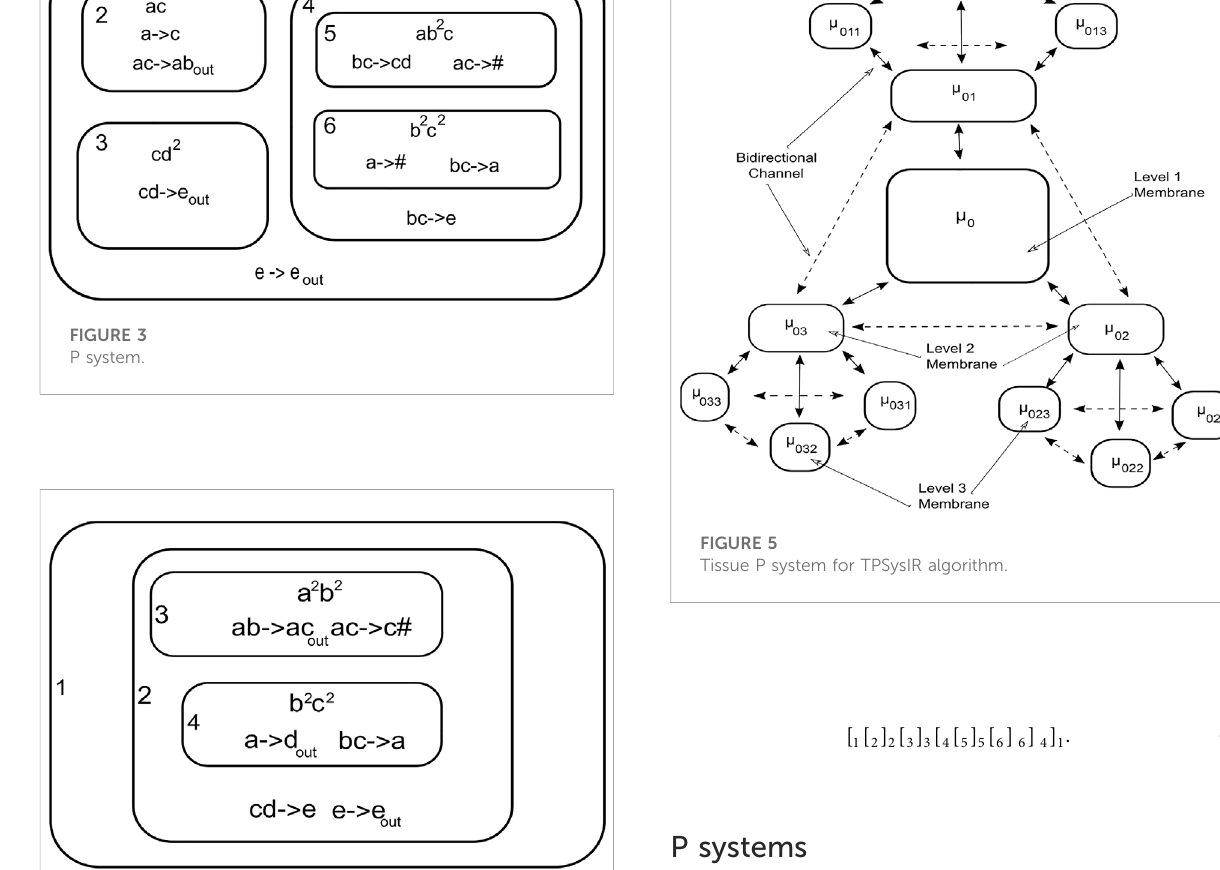
FIGURE 4 P system.